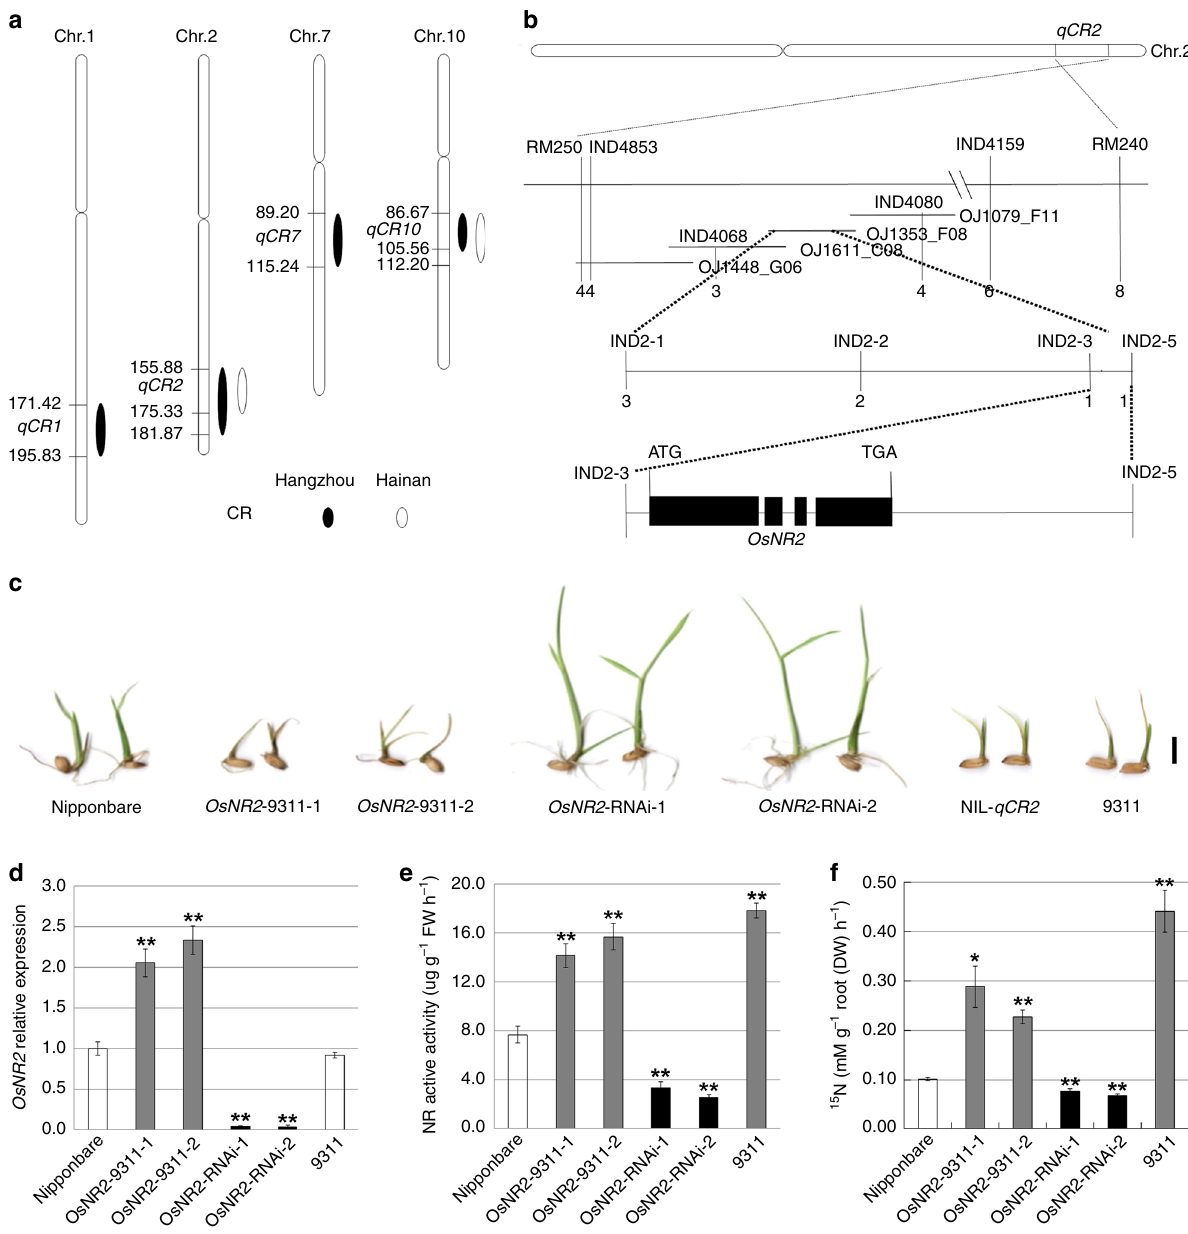
Fig. 1 OsNR2 allelic variation confers the qCR2 , and affects NR active activity and 15 NO 3 - uptake. a ClO 3 − resistance (CR) QTL analysis of RILs from an indica (9311) × japonica (Nipponbare) cross, performed on seedlings germinated from seeds harvested in Hangzhou or Hainan (see Methods). Major QTLs are shown, with numbers indicating genetic map position (cM) on each chromosome. b Fine mapping of qCR2 with a residual heterozygote line (RHL) F 2 population. Using a panel of linked markers (Supplementary Table 2), qCR2 was pin-pointed to a 6.4 kb region (Chr.2, between markers IND2-3 and IND2- 5) containing OsNR2 . Numbers of recombinants between each marker and qCR2 are shown. OsNR2 structure is shown, black boxes represent exons. c Relative seedling vigor indicates degree of ClO 3 − resistance (Nipponbare harboring constructs for expression of the 9311 OsNR2 allele driven by the 9311 OsNR2 promoter ( OsNR2 -9311-1 and OsNR2 -9311-2) or of OsNR2 RNAi ( OsNR2- RNAi-1 and OsNR2- RNAi-2); see Supplementary Fig. 1). d Leaf OsNR2 mRNA abundance, e leaf NR active activity, f 15 NO 3 − uptake activity of roots exposed to 1.25 mM 15 NO 3 − . Value is mean ± s.d. ( n = 3 for d – f ). Error bar represents s.d. * and ** respectively indicate least signi fi cant differences at the 0.05 and 0.01 probability level compared with Nipponbare. The source data underlying Fig. 1d – f are provided as a Source Data fi